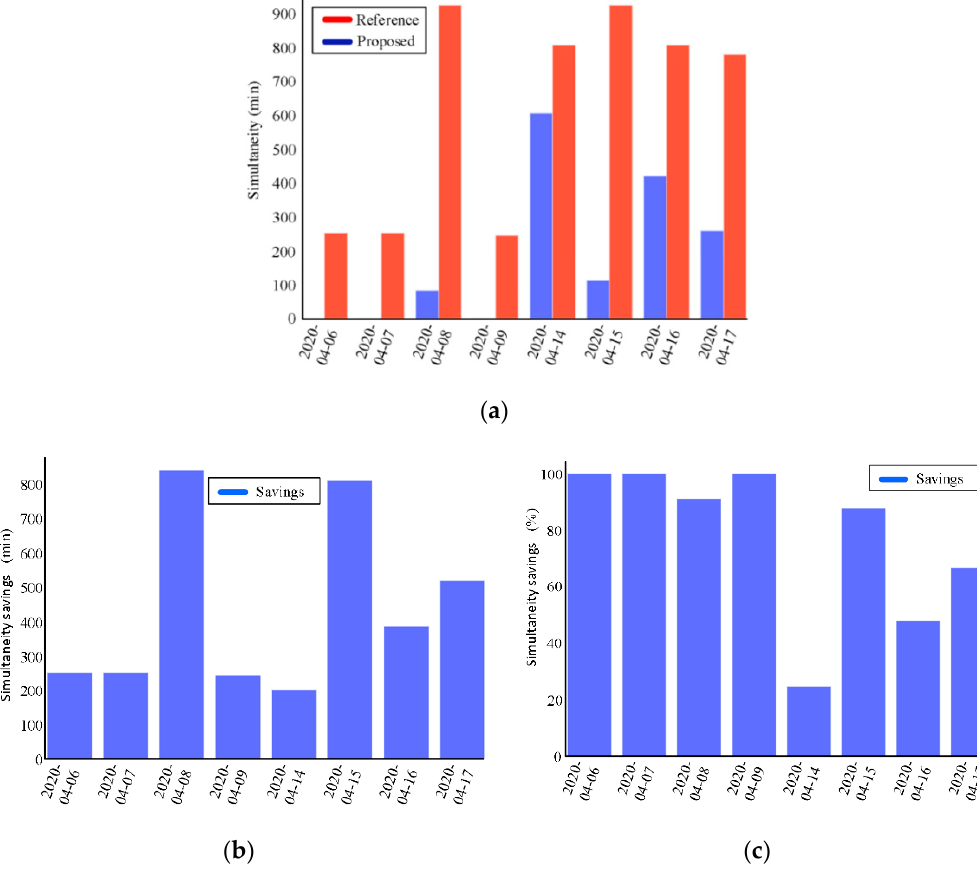
Figure 10. Simultaneity results. ( a ) Simultaneity of the proposed method compared with the reference. ( b ) Minutes saved with the proposed method vs. reference. ( c ) Percentage of simultaneity that it supposes.